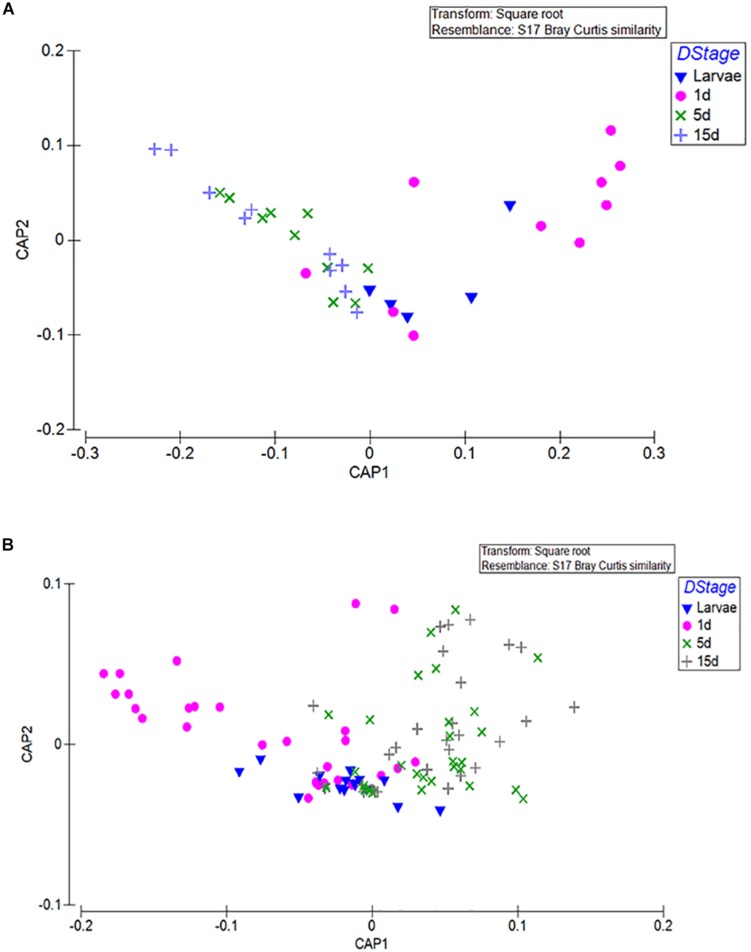
CAP was used to find axes that best discriminate the groups of interest. In this analysis, clustering based on developmental stage and age was tested. (A) The mean values of the 3 replicates for the male and female samples are displayed. (B) All replicates are displayed. L, larvae; M, males; F, females; 1D, 1-day old, unfed; 5D, 5–10-days old; 15D, 15–20-days old.